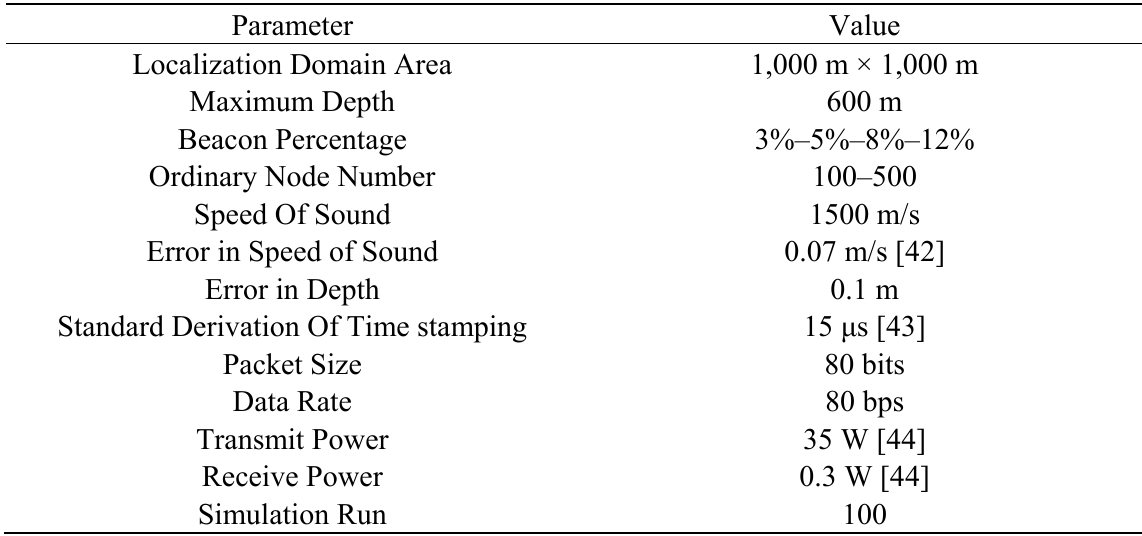
Table 3. Simulation